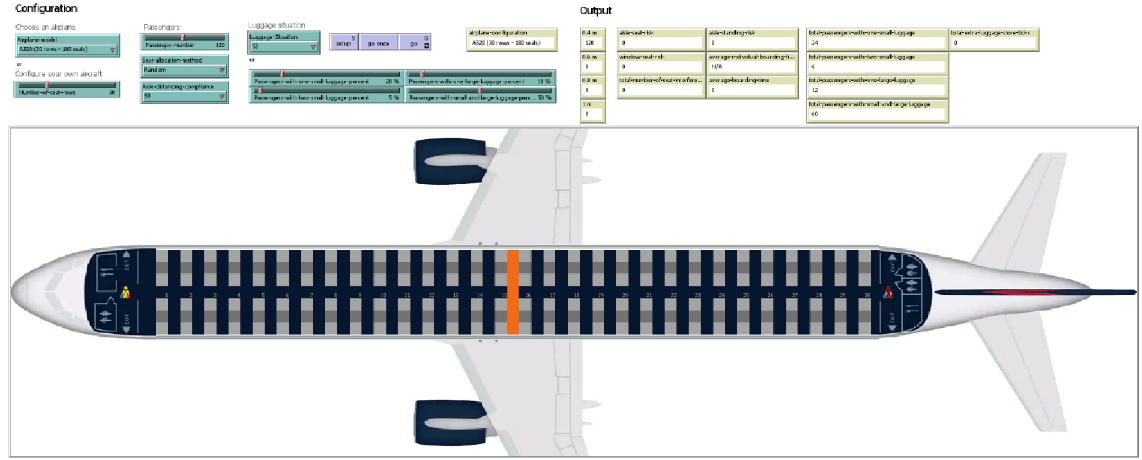
Fig 8. GUI of the agent-based